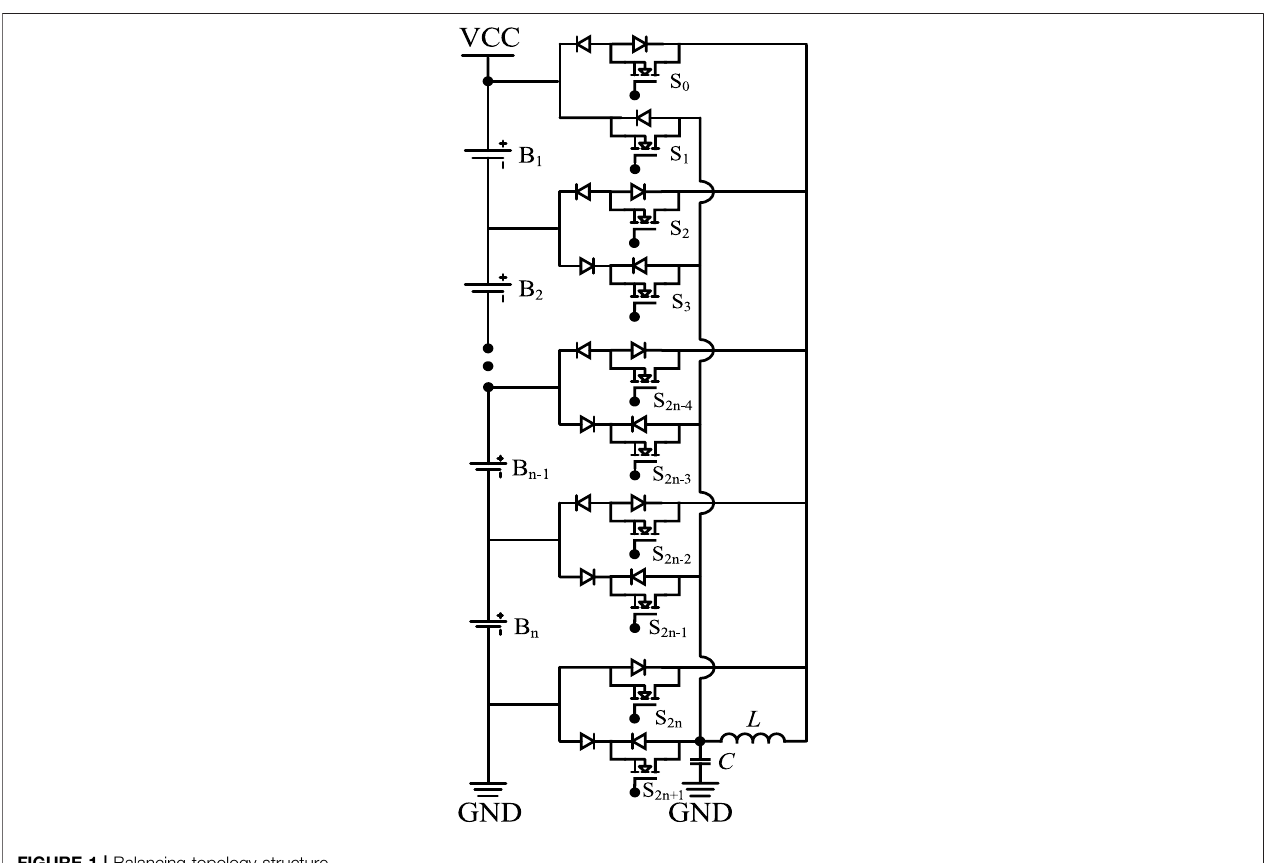
FIGURE 1 | Balancing topology